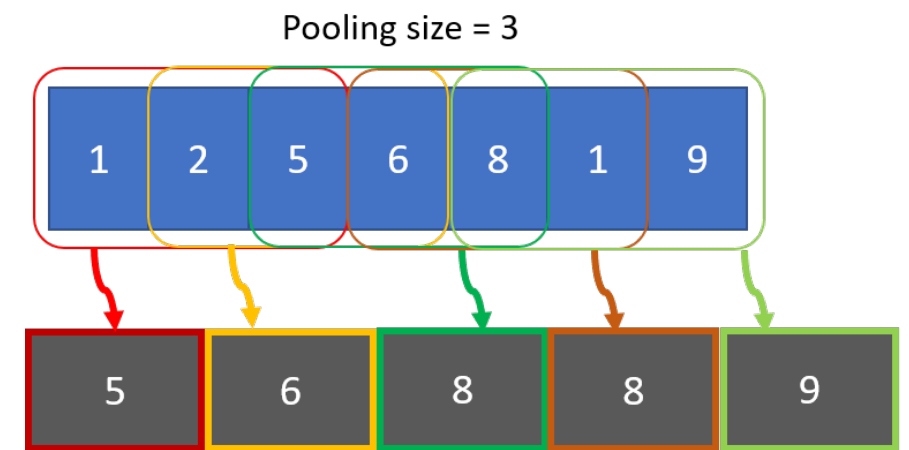
Figure 2. 1D MaxPooling with pooling window size of